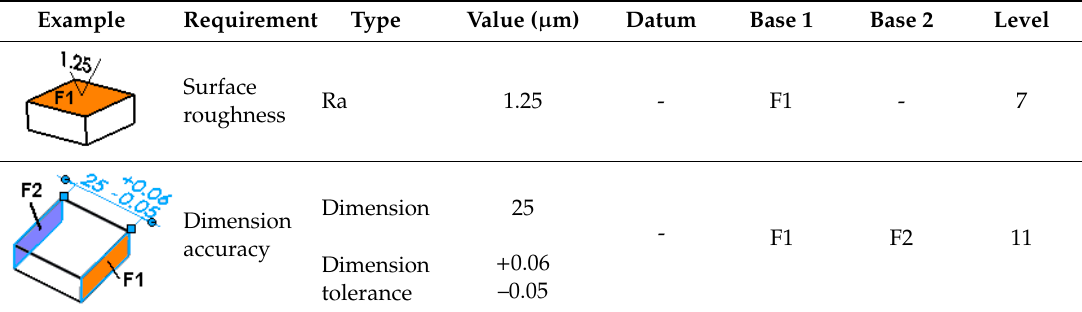
Table 2. Examples of technical requirement extraction data.